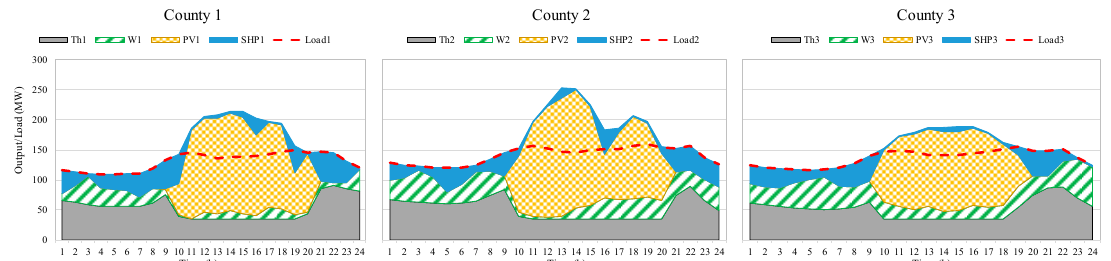
Figure 9. Output process of the county power stations in the cooperative mode.